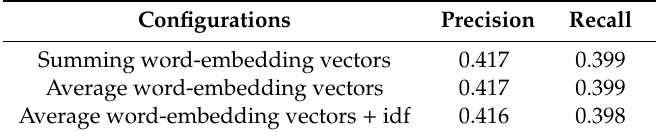
Table 5. The results of di ff erent configurations for constructing a sentence vector.